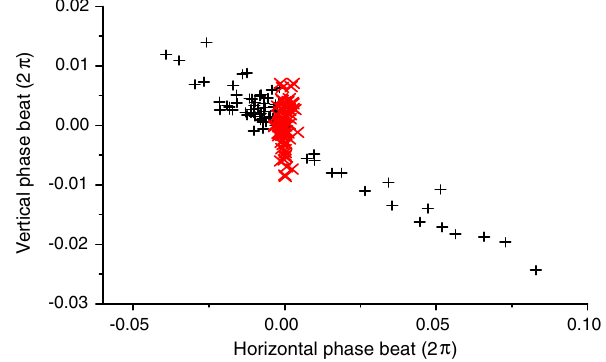
FIG. 5. Phase-beat measurements before and after the cable installation. Black/red points show the phase-beat measurement before/after the cable